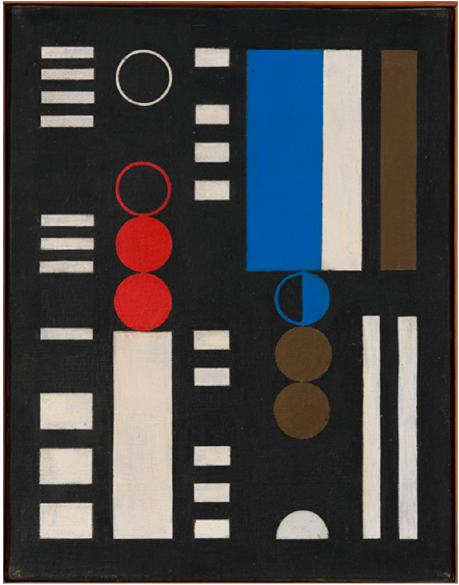
Figure 16. Sophie Taeuber-Arp, Composition verticale à rectangles, cercles et barres, 1930. Oil on canvas. 29 cm × 22.5 cm. Fondazione Marguerite Arp-Hagenbach, Locarno. © SIK-ISEA, Zürich (photo Philipp Hitz), used by permission.